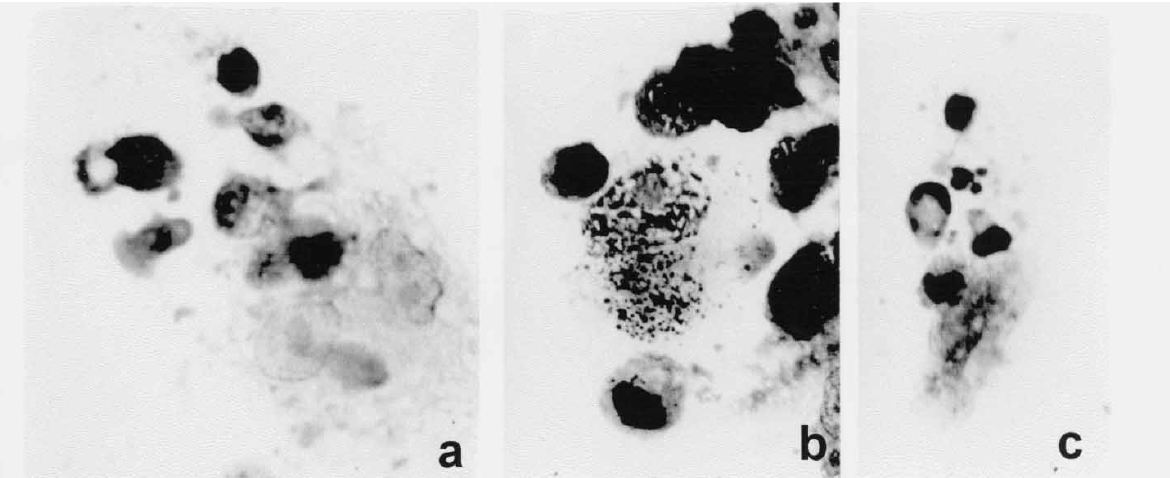
Fig. 1. (a) Allogeneic large lymphocytes lyse the cytoplasm of two sarcoma cells. (b) Two autologous lymphocytes kill two melanoma cells by causing nuclear clumping. (c) Autologous lymphocytes attacking fibrosarcoma cell undergo nuclear clumping and die while